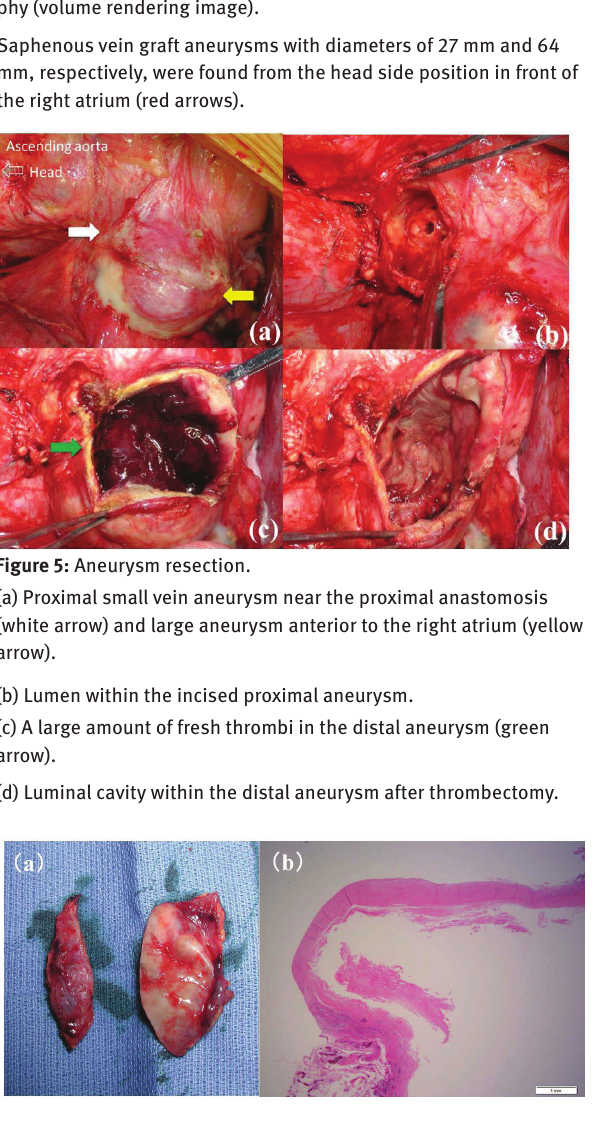
Figure 6: Resected vein graft aneurysm (a) and its microscopic findings (b) The wall thickness of resected vein graft aneurysm was thinner than the healthy segment. Normal three-layer structure was observed microscopically in the enlarged segment of the resected vein graft aneurysm (hematoxylin-eosin stain).